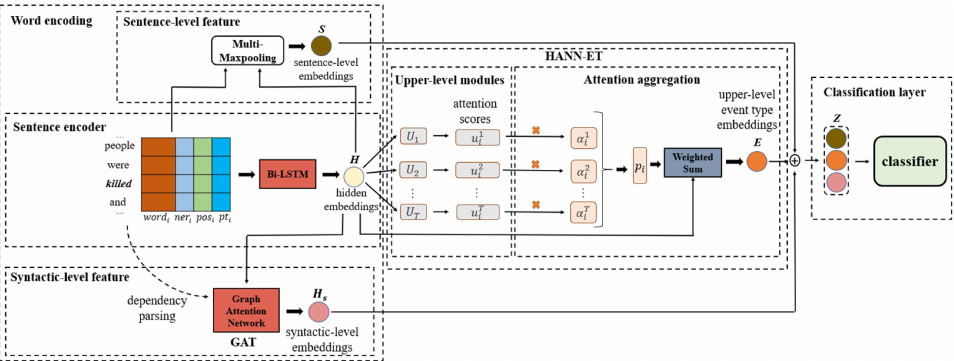
Figure 2. The overall architecture of